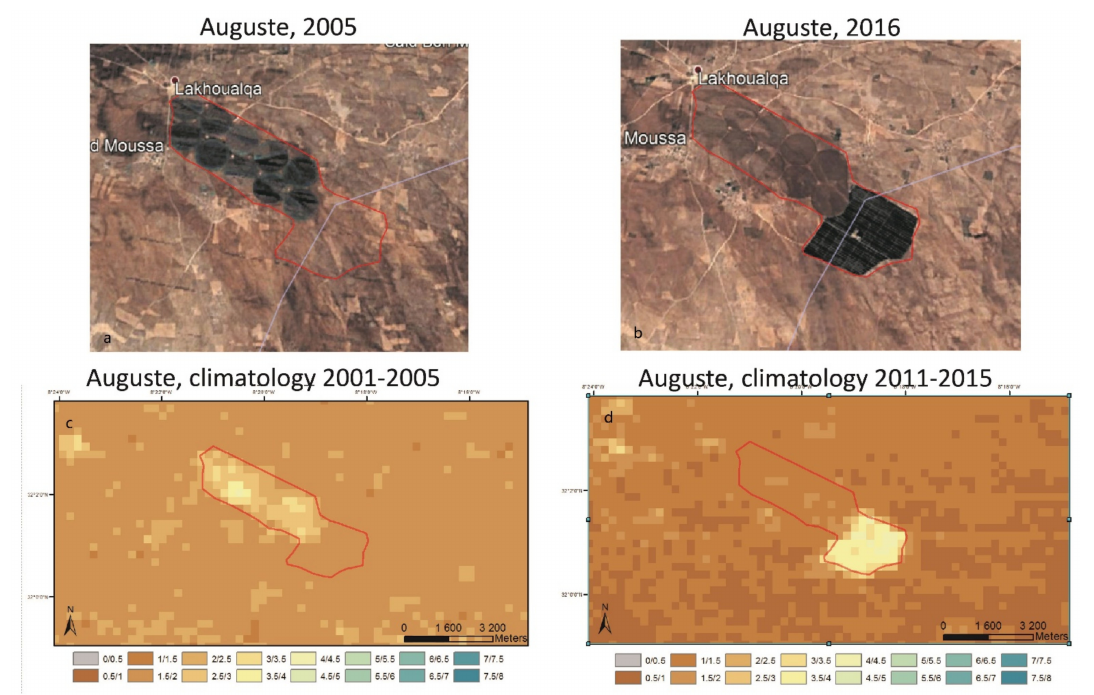
Figure 10. Evolution of the irrigated areas in the north of Marrakech city: ( a ) Google Earth image of August 2005); ( b ) Google Earth image of August 2016; ( c ) monthly evapotranspiration averages through August for the 2001–2005 period; ( d ) monthly evapotranspiration averages through August for the 2011–2015